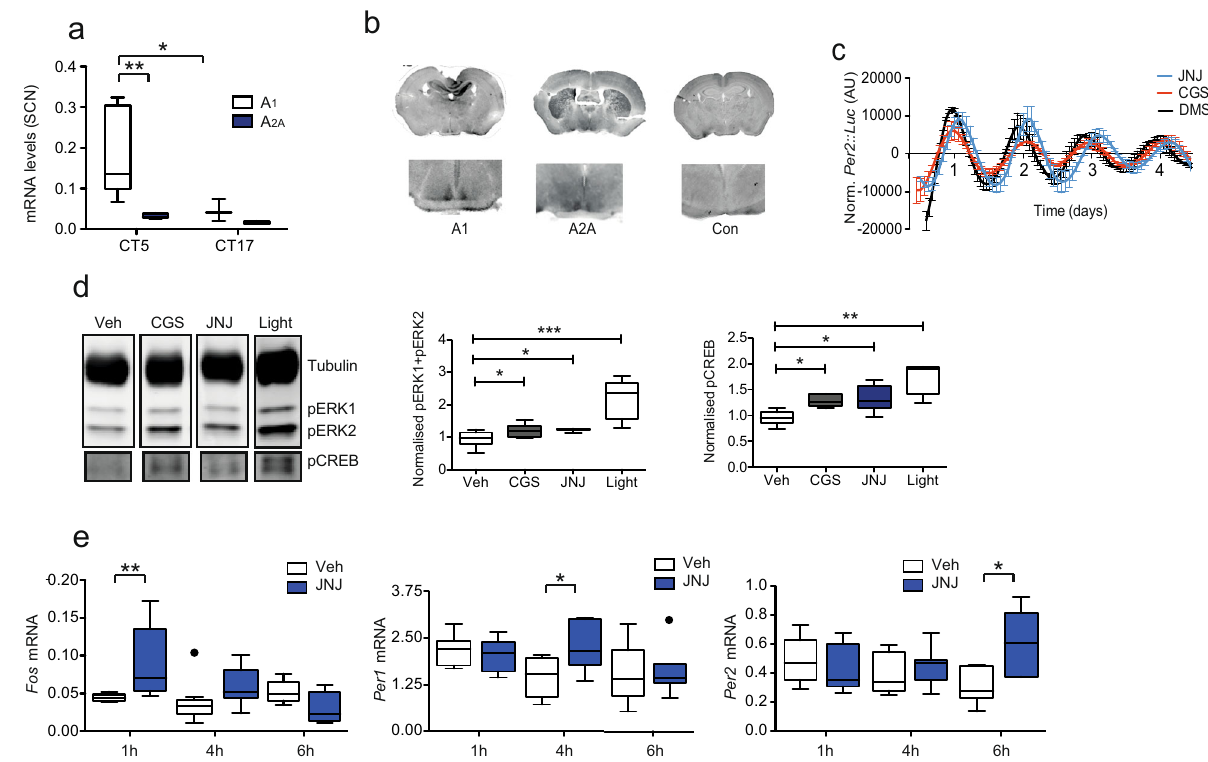
Fig. 3 The SCN expresses adenosine receptors and responds to adenosine receptor antagonists. a Expression of adenosine receptor ( Adora ) subtypes within the mouse SCN at two different circadian times ( n = 5, A 1 at a higher concentration compared to A 2A p = 0.0138, and at higher levels at CT5 (0.178 ± 0.04) compared to CT17 (0.073 ± 0.03) p = 0.0223, two-way ANOVA with Bonferroni post-hoc test). b Immunohistochemistry for A 2A and A 1 receptor subtypes showing expression within the SCN (inset). c SCN slice cultures from Per2::Luc mice treated with the A 2A /A 1 antagonists CGS15943 (CGS) 10 μ M (red, period length 25.1 ± 0.1 h, n = 3) and JNJ40255392 (JNJ) 10 μ M (blue, period length 26.24 ± 0.3 h; n = 5; DMSO 23.1 h ± 0.3 h n = 5; p = 0.0000076439 for CGS and 0.0484 for JNJ, Tukey ’ s multiple comparisons test. d Western blot with antibodies against pERK1/2 (pT202/Y204 - pERK) and pCREB (pS133) within the SCN collected from mice 45 min after i.p. injection of CGS or JNJ at 5 mg/kg at CT6, SCN collected from mice exposed to a 30 min CT16 light pulse included for comparison ( n = 7 from two experiments of n = 3 and n = 4, uncut blots shown in Supplementary material, one-way ANOVA with Bonferroni post-hoc test). Box plots show relative expression. e Increases in Fos , Per1 , and Per2 mRNA within the SCN after i.p. injection of JNJ at CT6 after 1, 4 and 6 h respectively, n = 6 – 10. p = 0.0387 for Fos , 1 h; p = 0.0183 for Per1 , 4 h and p = 0.0322 for Per2 , 6 h, one-way ANOVA with Bonferroni post-hoc test. Tukey ’ s box plots used throughout (central line – mean, box represents 25 th to 75 th percentile data, whiskers are 1.5 interquartile